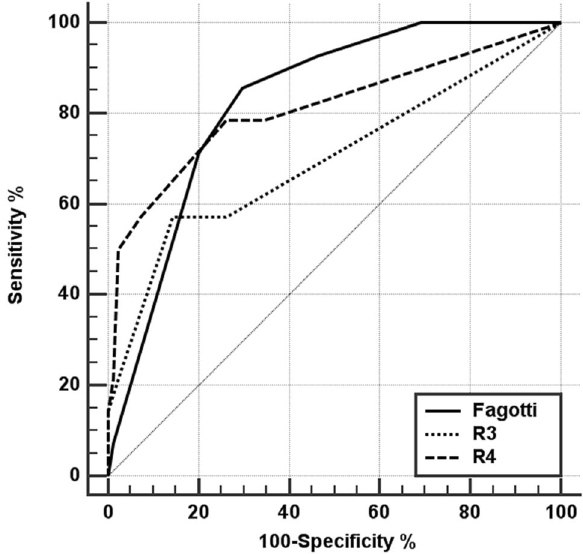
Figure 2. Comparative graph of the ROC curves for the different